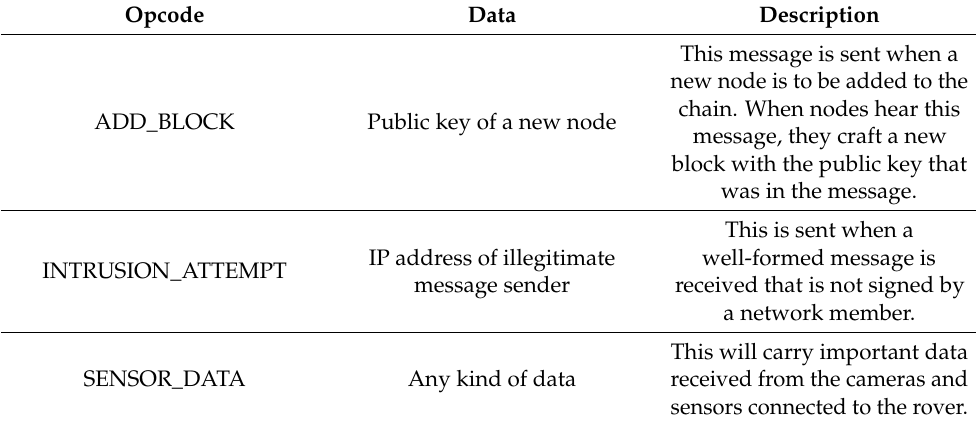
Table 3. Network